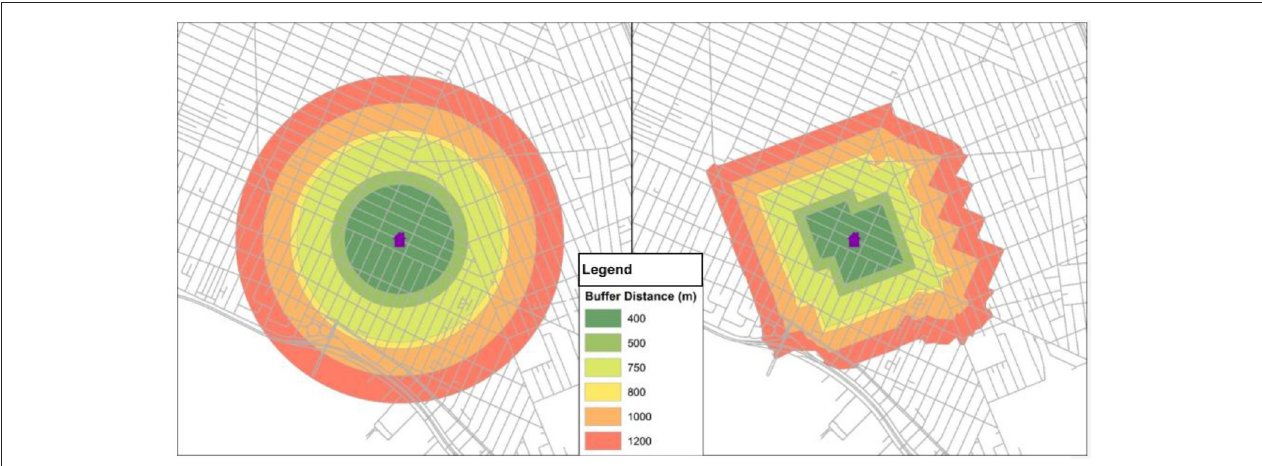
FIGURE 1 | Neighborhood definitions in the GeoFLASHE dataset: Example of Circular and Street Network Buffers. The example circular buffers (Left) and street network buffers (Right) are shown for various distances from the participants’ home location ranging from 400 to 1,200m. The publicly available GeoFLASHE dataset includes neighborhood variables for each of these 12 neighborhood definitions varying in buffer shape (circular, street network) and size (400, 500, 750, 800, 1,000, and 1,200m from the participant’s home location) ( 20).